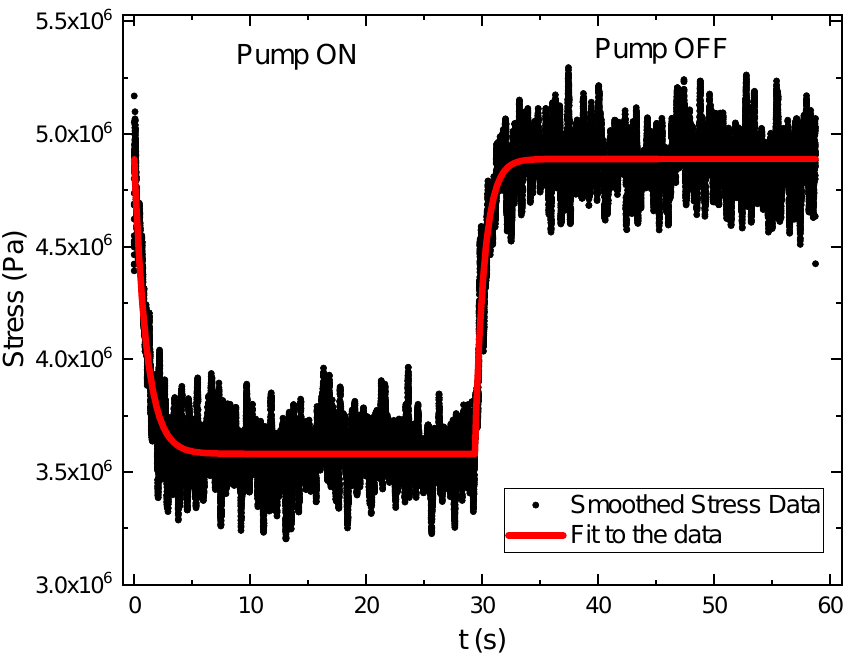
Figure 15. Typical smoothed stress versus time data and a fit to Equations (16) and (17) for one full On/OFF